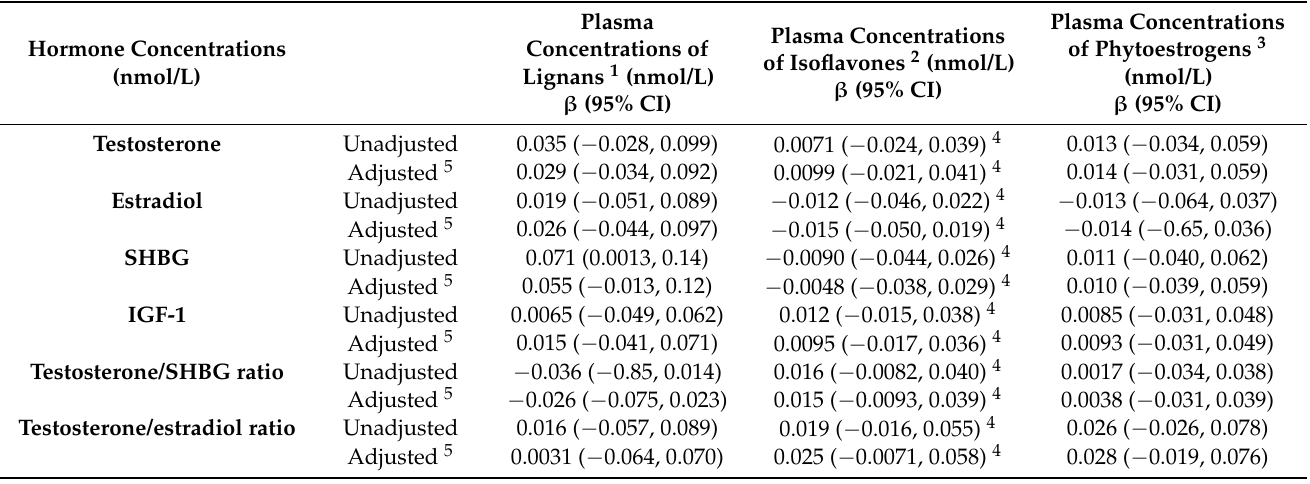
Table 5. Linear regression analyses between plasma concentrations of phytoestrogens (explana- tory variables) and serum concentrations of hormones (outcomes) in patients with prostate cancer ( n =